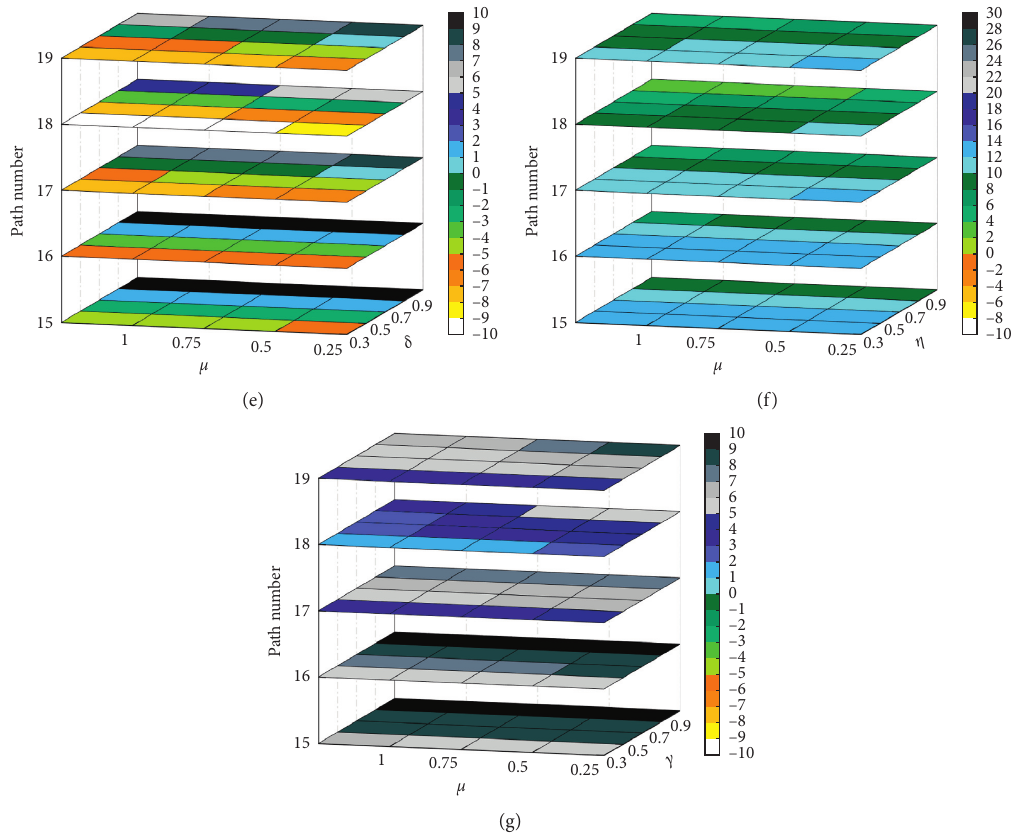
Figure 3: The variation of the CPV with model parameters. (a) Sensitivity analysis of μ and θ . (b) Sensitivity analysis of μ and ρ . (c) Sensitivity analysis of μ and ζ a . (d) Sensitivity analysis of μ and λ . (e) Sensitivity analysis of μ and δ . (f) Sensitivity analysis of μ and η . (g) Sensitivity analysis of μ and c